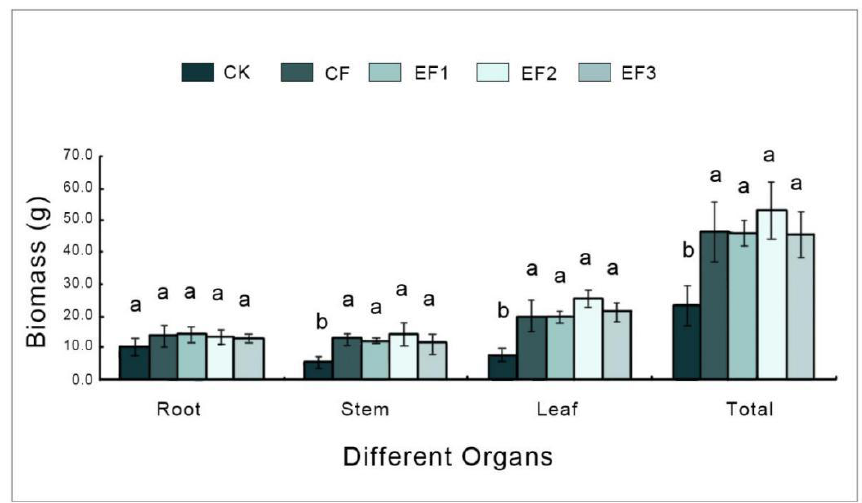
Figure 3. Organ biomass of Chinese fir rooted cuttings influenced by different fertilization levels (Different letters in the same histogram indicate significant difference at 0.05 level). Table 1. Ratio of aboveground biomass and belowground biomass under different fertilization levels.